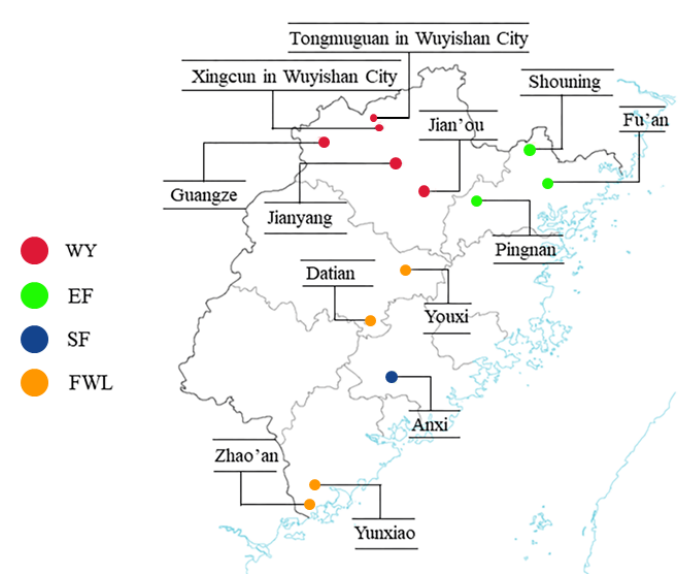
Figure 1. Sample distribution of Fujian tea plant accessions used in this study